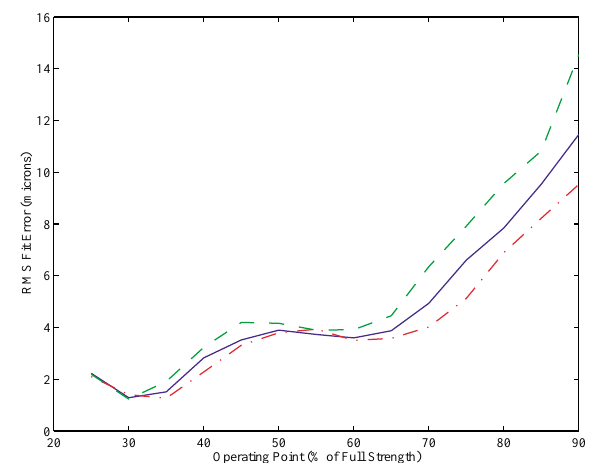
FIG. 5. (Color) rms alignment fit error due to permeability mismatch in NLC main linac quads as a function of design excitation, for maximum strength excursions of 10% of the design strength. The three curves are defined identically with Fig. 4. Note the similarity in amplitude and overall shape for 1% and 10% maximum